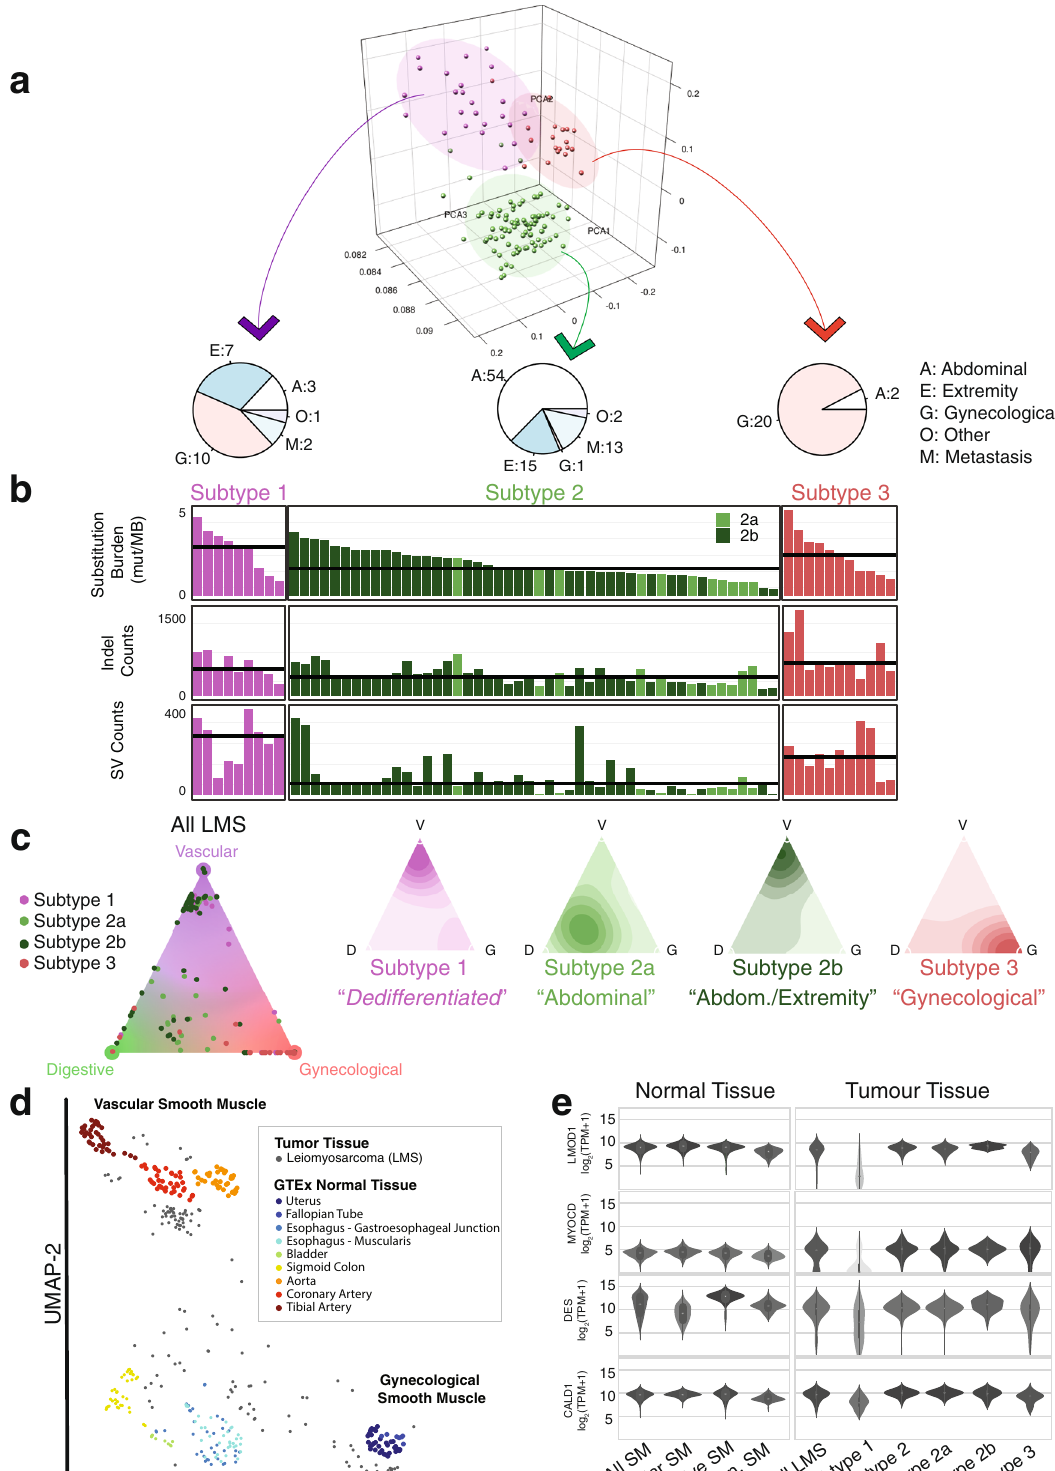
(Supplementary Fig. 4). Out of the 130 RNA samples, three cases (2.3%) clustered apart from the others –– falling outside the three LMS subtypes. We reviewed the histopathology from each case but did not fi nd any further evidence to support a change in diagnosis. In one instance, a gastric LMS resembled stomach